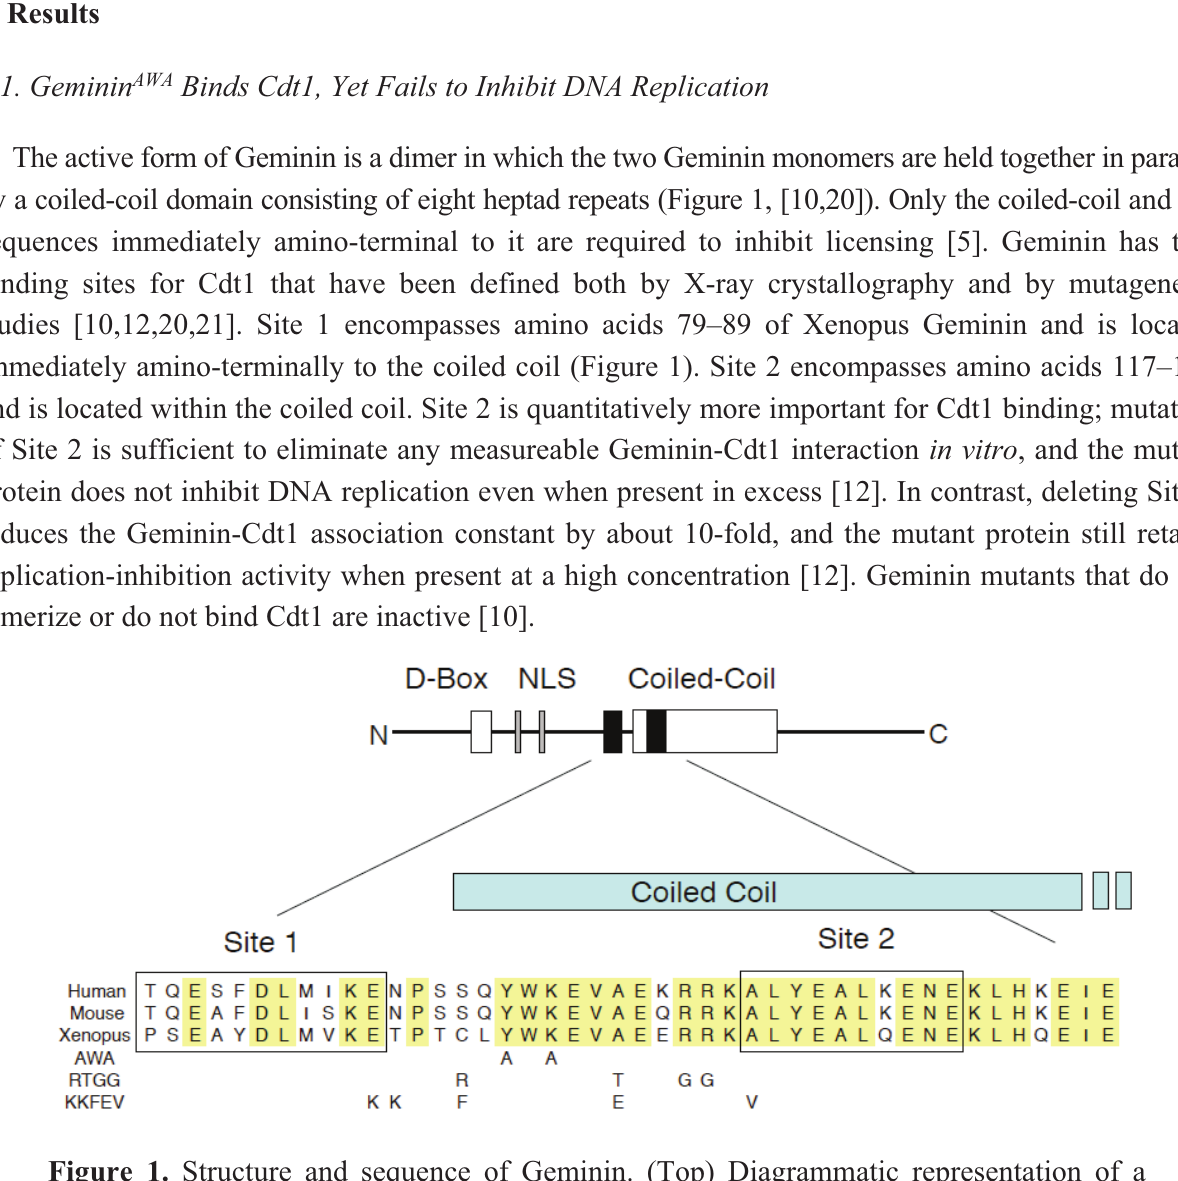
Figure 1. Structure and sequence of Geminin. (Top) Diagrammatic representation of a Geminin monomer. Black bars, Cdt1 binding sites; D-box, destruction box required in cis for ubiquitylation; NLS, nuclear localization signal. (Bottom) Sequence alignment of Human, mouse and Xenopus Geminin. Conserved residues are shaded. Mutated residues in Geminin AWA , Geminin RTGG and Geminin KKFEV are